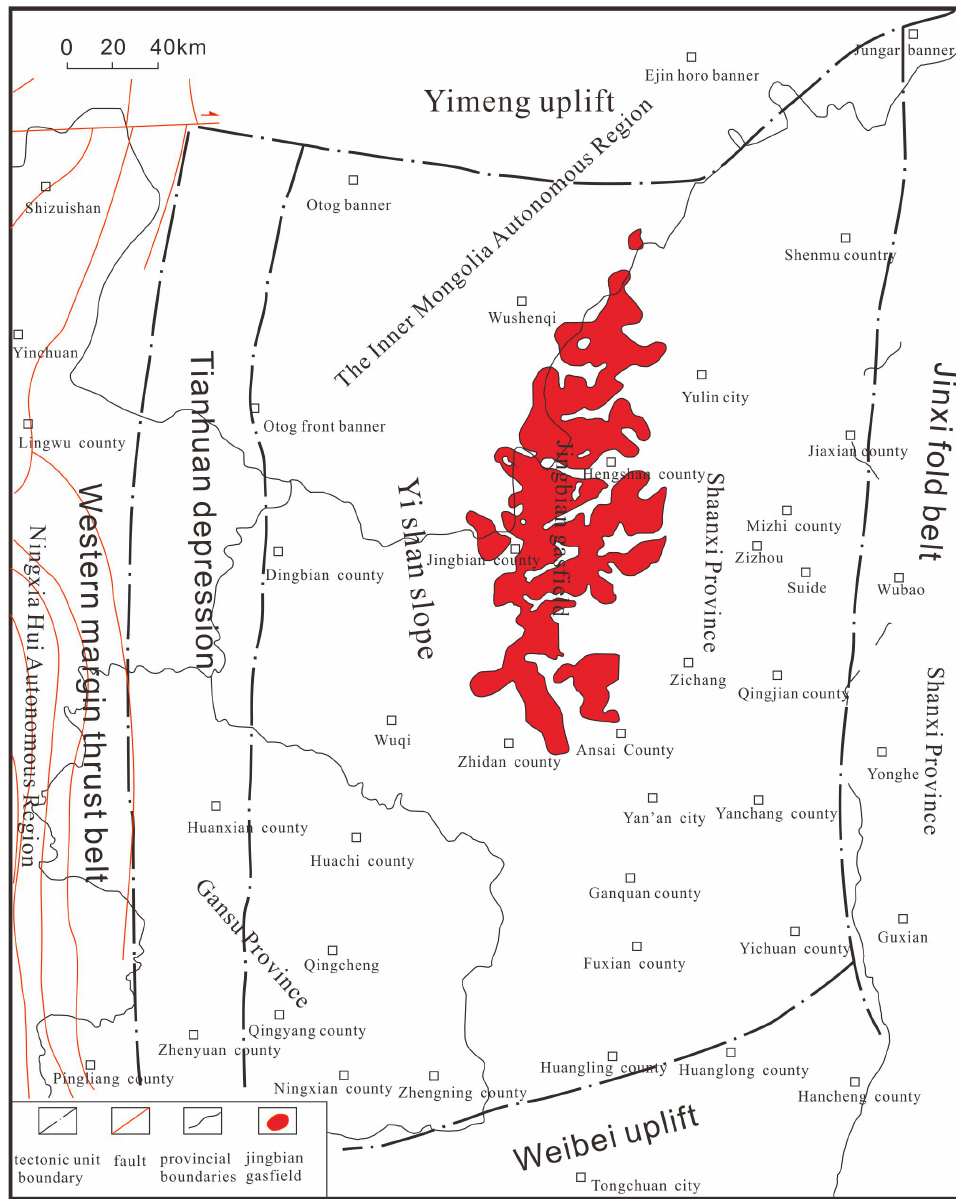
Figure 1. Division of tectonic units and location of the Jingbian gas field in the Ordos Basin.